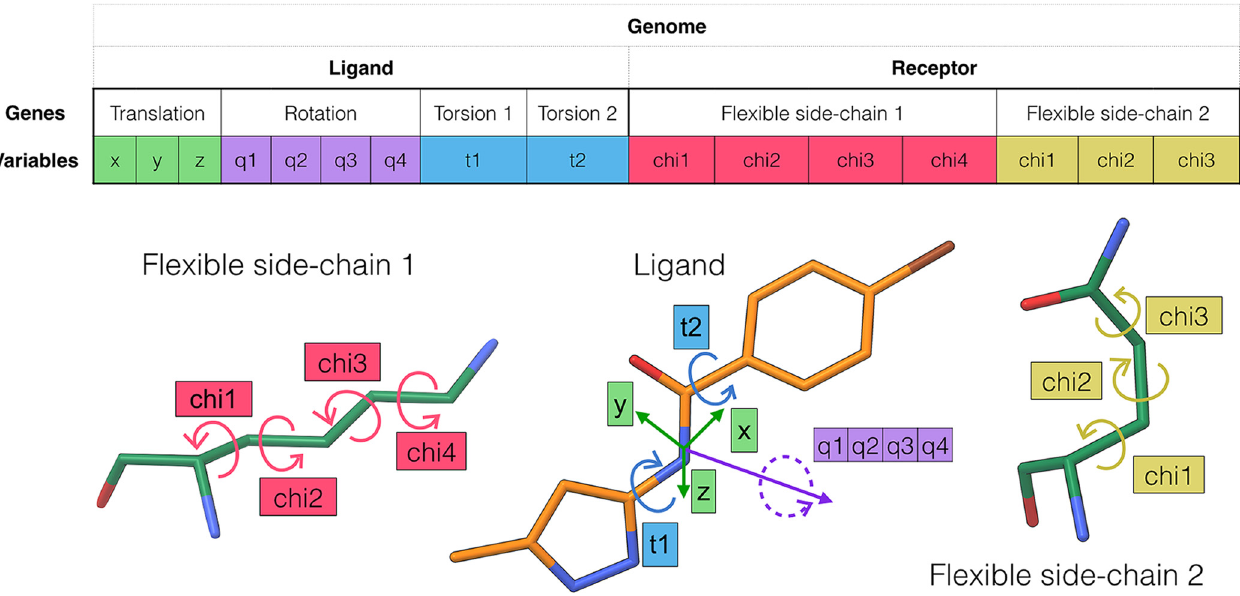
Fig 1. Genome used by ADFR to encode the docking of a flexible ligand into a receptor with two flexible side-chains. This figure illustrates a genome optimized by the GA implemented in ADFR for solving the problem of docking a flexible ligand with two rotatable bonds into a receptor with two flexible side- chains. The genome is the set of variables to optimize. A given set of values for these variables constitutes a docking solution also called an individual. Variables are grouped into the following genes: the ligand translation (3 values: x, y, z), rotation (4 values: quaternion), and conformation (1 torsion angle per ligand rotatable bond), and the receptor conformation ( χ angles for each flexible receptor